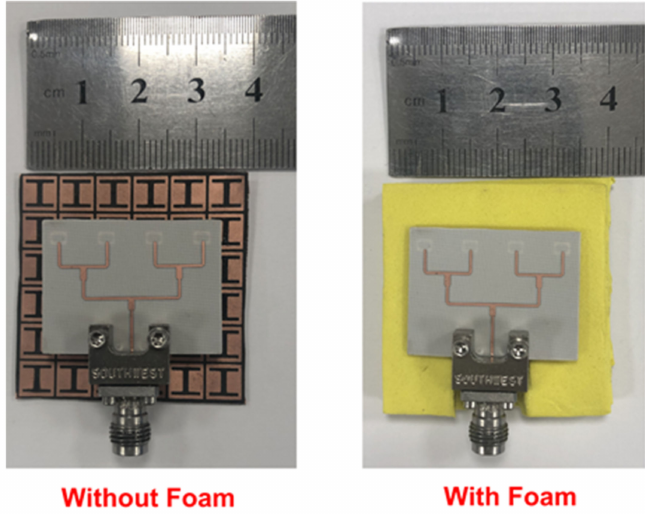
Figure 14. The fabricated antenna photo with AMC.